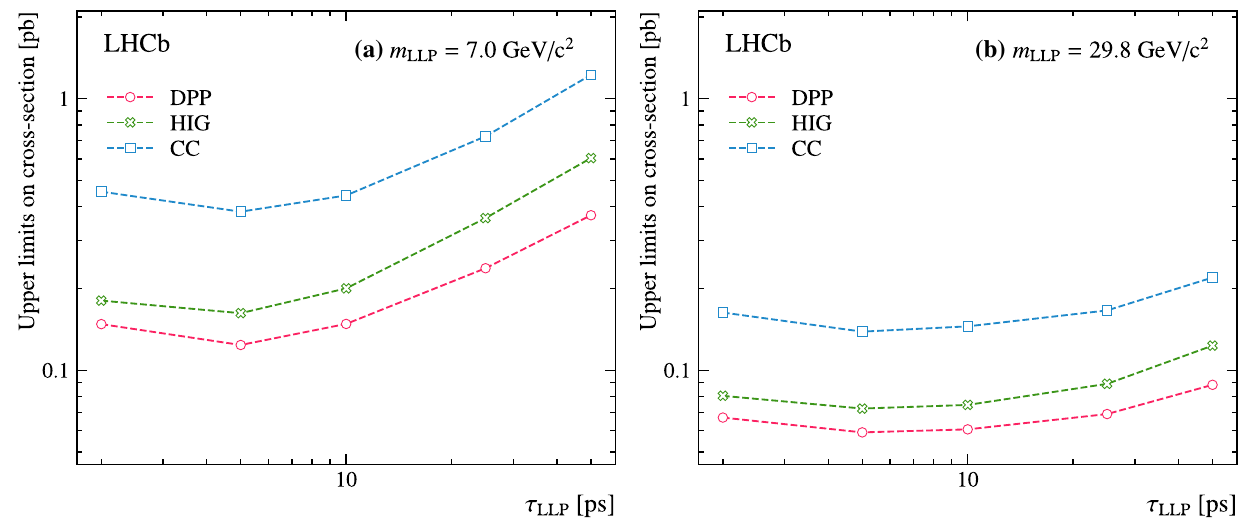
Fig. 7 Observed upper limits on the production cross-sections times branching fraction for a m LLP = 7GeV/ c 2 and b m LLP = 29 . 8GeV/ c 2 as function of τ LLP for the DPP, HIG and CC production